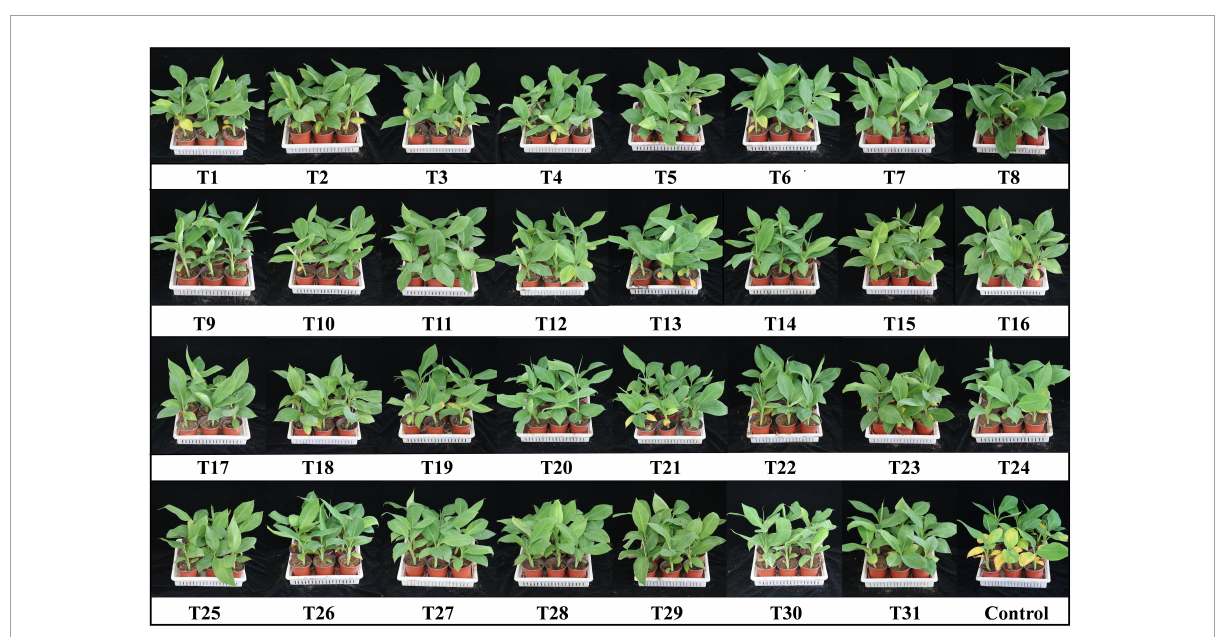
FIGURE2 Symptoms of Fusarium wilt of banana observed on infected banana seedlings 15 days after inoculation.